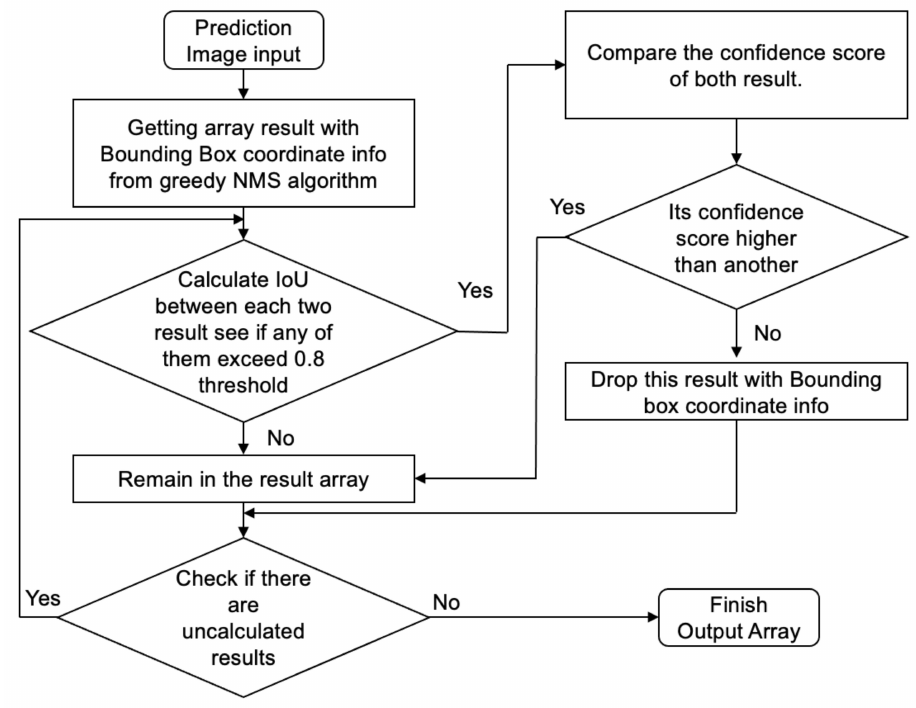
Figure 8. Architecture of part (iii) in Figure 5: workflow (loop) of the modified NMS algorithm across multiple